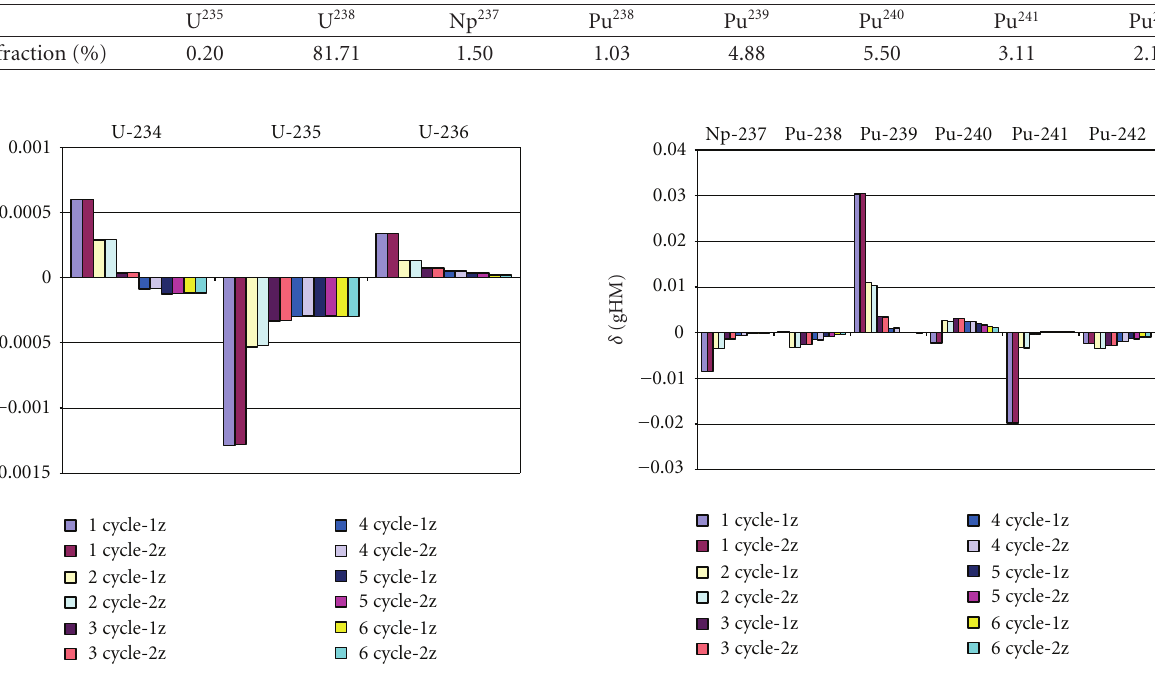
Table 5: GCFR initial HM composition (82% at DU + 18% Pu+Np from PBMR; please see Table 4).